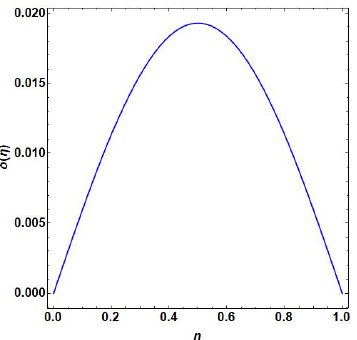
Figure 1. Solution of the boundary value